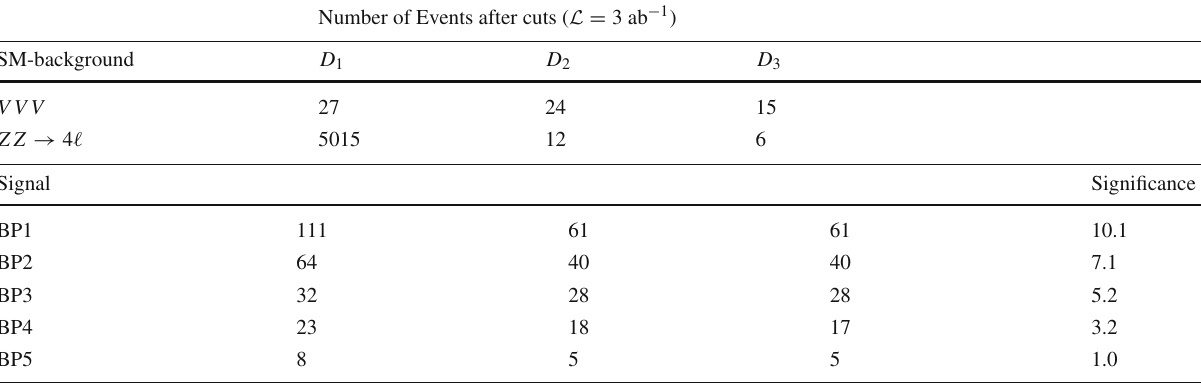
Table 16 The cut-flow for signal and backgrounds along with the significances for BP1, BP2, BP3, BP4 and BP5 at 14 TeV HL-LHC for 3 ab − 1 integrated luminosity for the pp → 4 (cid:3) + E T / channel